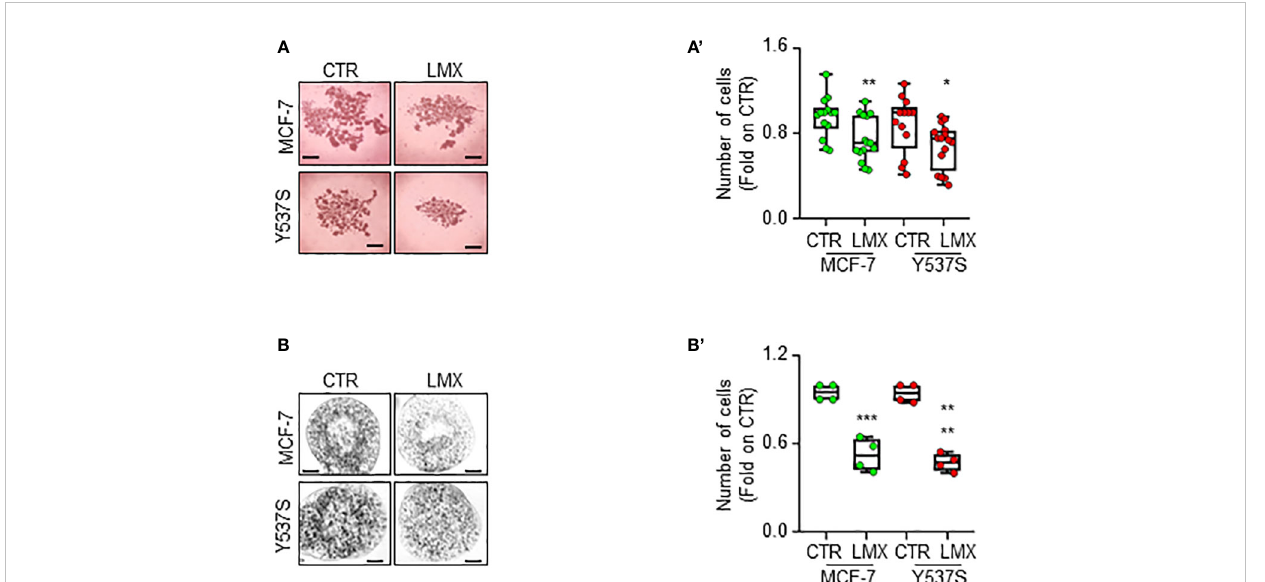
FIGURE 9 Effect of LMX in 3D-models of breast cancer. Images (A, B) and quantitation (A ’ , B ’ ) of tumor spheroids surface area (A, A ’ ) and alginate-based cultures (B, B ’ ) generated in MCF-7 and Y537S cells, treated at time 0 with LMX (1 m M) or left untreated (CTR), for 7 days. The number of replicates is given as solid dots in the graphs. Signi fi cant differences with respect to the CTR sample were determined by unpaired two-tailed Student ’ s t-test: ** p -value<0.01; * p-value<0.05. Scale bars equal to 50.0